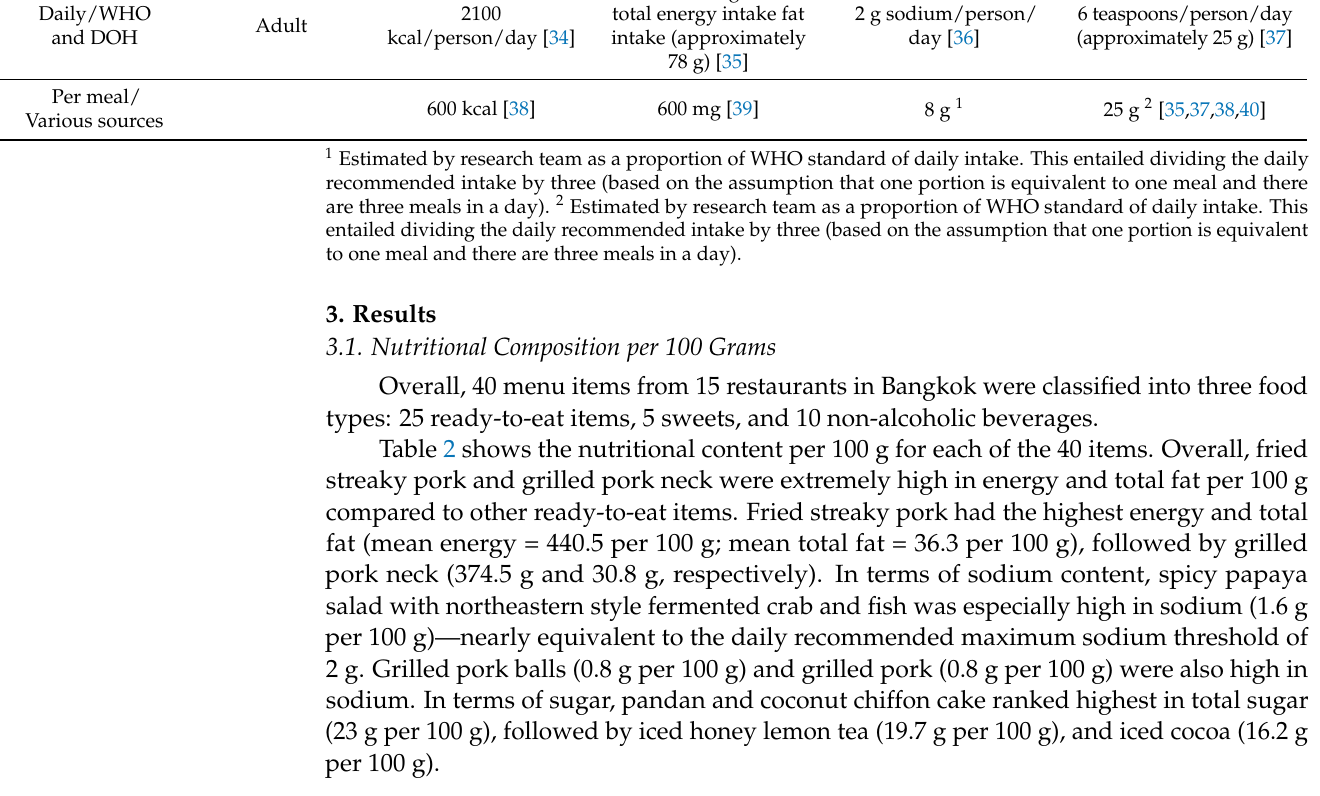
Table 2. Nutritional content of menu